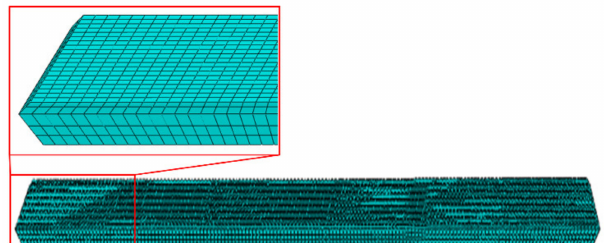
Figure 2. Mesh division of the plate in the three-dimensional (3D) model.